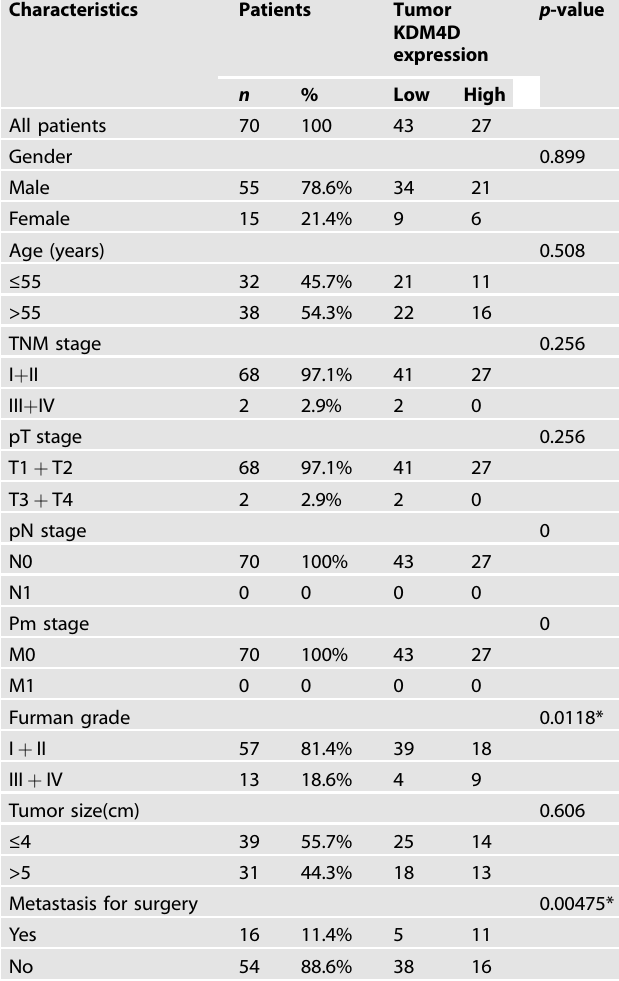
Table 1. Clinicopathological characteristics of ccRCC patients in relation to KDM4D expression